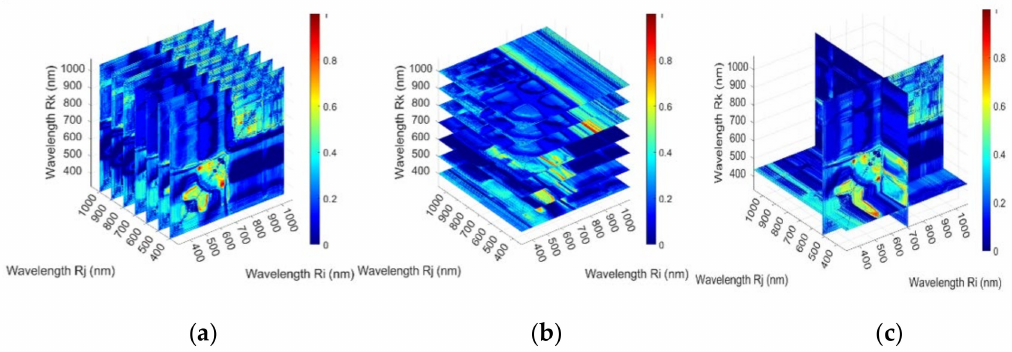
Figure 5. The 3D KI slice map of the ideal sequence and damage level sequence on RPSI. ( a ) Vertical slice, ( b ) horizontal slice, ( c ) best